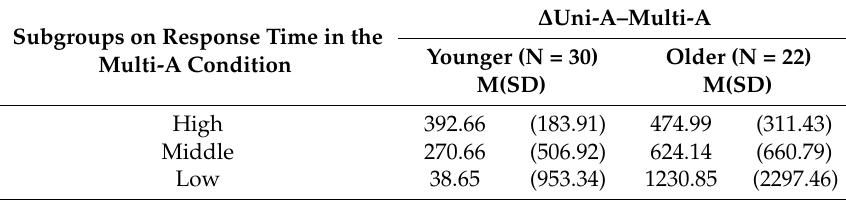
Table 3. Enhancement between Uni-A and Multi-A in the Multi-A